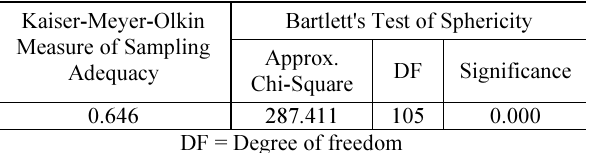
Table 6. KMO and Bartlett's Test